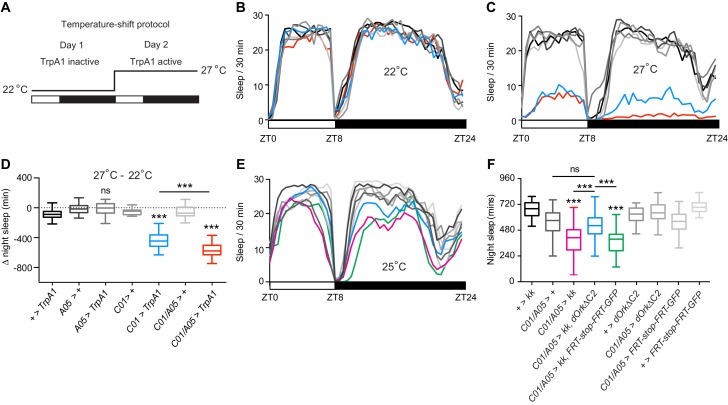
Sleep loss in Nca knockdown flies is caused by enhanced excitability of C01/A05-neurons.(A) Experimental paradigm for acute activation of A05 or C01-neurons. 22°C: non-activating temperature for TrpA1. 27°C: activating temperature. Sleep levels were recorded over two days in 8L: 16D conditions. (B–C) Mean sleep levels across 8L: 16D following expression of TrpA1 in A05-, C01- or A05- and C01-neurons (and associated controls) at 22°C (B) or 27°C (C). (D) Median change in night sleep levels (Δ night sleep) following the shift from 22°C on day 1°C to 27°C on day 2. + > TrpA1: n = 53, A05 > +: n = 23, A05 > TrpA1: n = 68, C01 > +: n = 24, C01 > TrpA1: n = 40, C01/A05 > +: n = 33, C01/A05 > TrpA1: n = 40. ns – p>0.05, ***p<0.001, as compared to TrpA1 or driver alone controls by Kruskal-Wallis test with Dunn’s post-hoc test (for C01 > TrpA1, A05 > TrpA1, or C01/A05 > TrpA1 compared to controls) or Mann-Whitney U-test (for C01/A05 > TrpA1 compared to C01 > TrpA1). (E–F) Inhibition of C01/A05-neurons by expressing dORKΔC2 rescues sleep loss due to Nca knockdown, while expression of dORKΔC2 does not change baseline sleep. Mean sleep patterns in 8L: 16D conditions are shown in (E). Median night sleep levels are shown in (F).+ > kk: n = 72, C01/A05 > +: n = 85, C01/A05 > kk: n = 95, C01/A05 > dORKΔC2, kk: n = 77, C01/A05 > kk, FRT-stop-FRT-GFP: n = 39, + > dORKΔC2: n = 57, C01/A05 > dORKΔC2: n = 73, C01/A05 > FRT-stop-FRT-GFP: n = 49, + > FRT-stop-FRT-GFP: n = 36. ns – p>0.05, ***p<0.001, Kruskal-Wallis test with Dunn’s post-hoc test.10.7554/eLife.38114.029Figure 8—source data 1.Sleep levels following excitation or inhibition of C01- and A05-neurons (simultaneously or in isolation), either in a wild type background or in parallel to Nca knockdown.Blank cells represent data from dead flies removed prior to analysis.